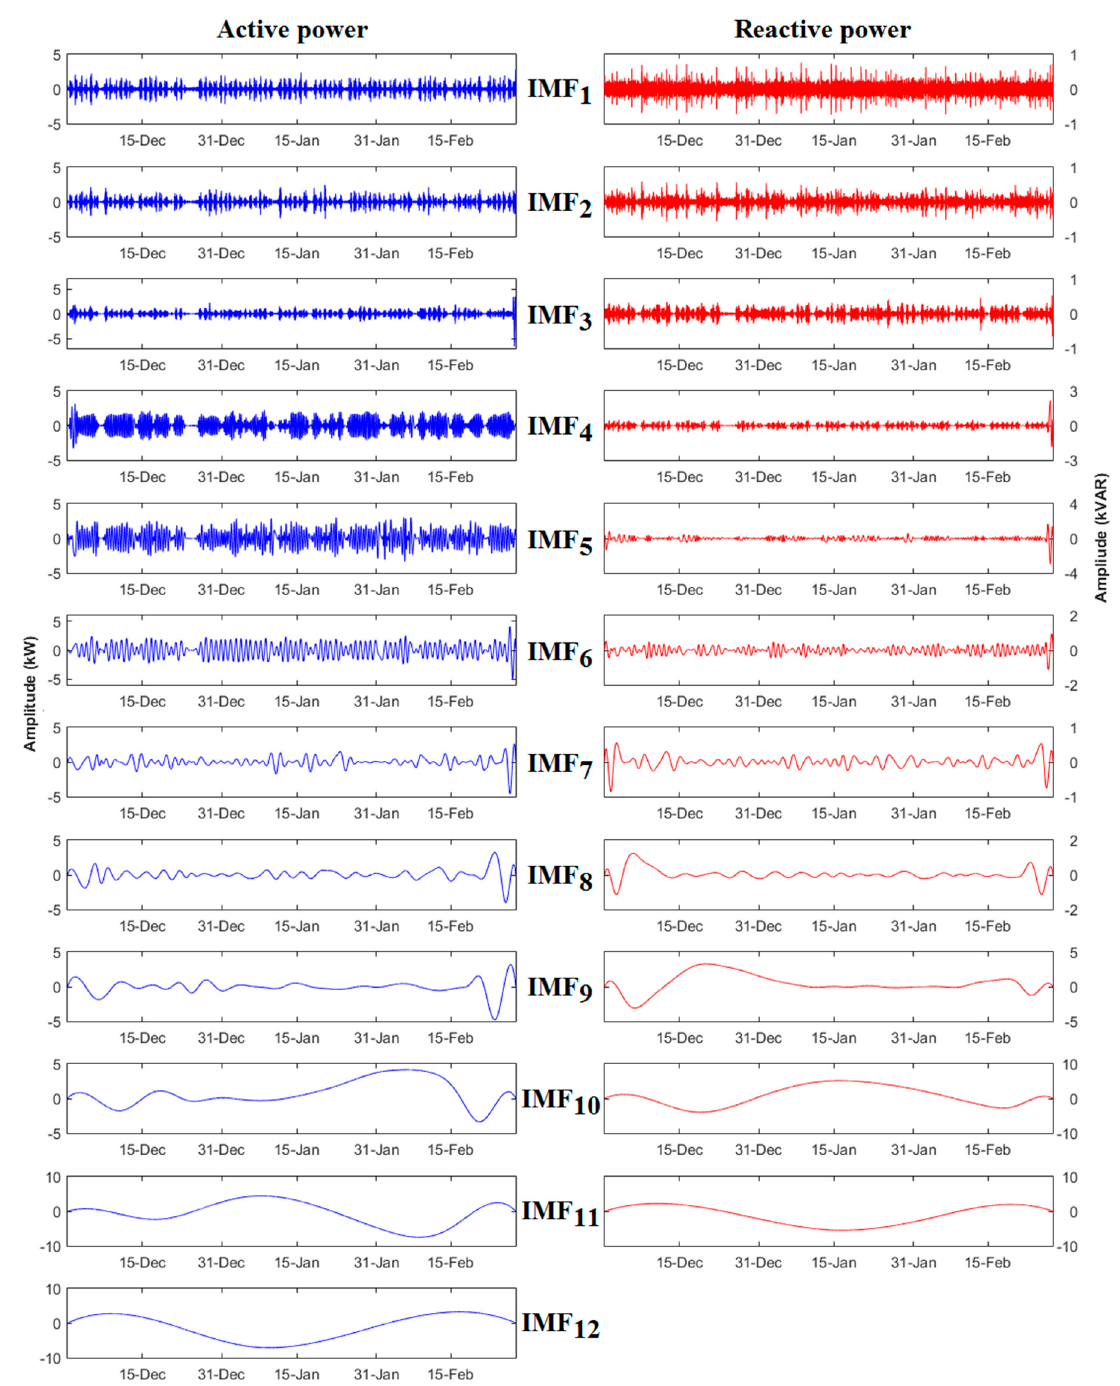
Figure 7. Time-domain amplitude of the IMFs of a restaurant user for the active power ( left column) and reactive power ( right column).